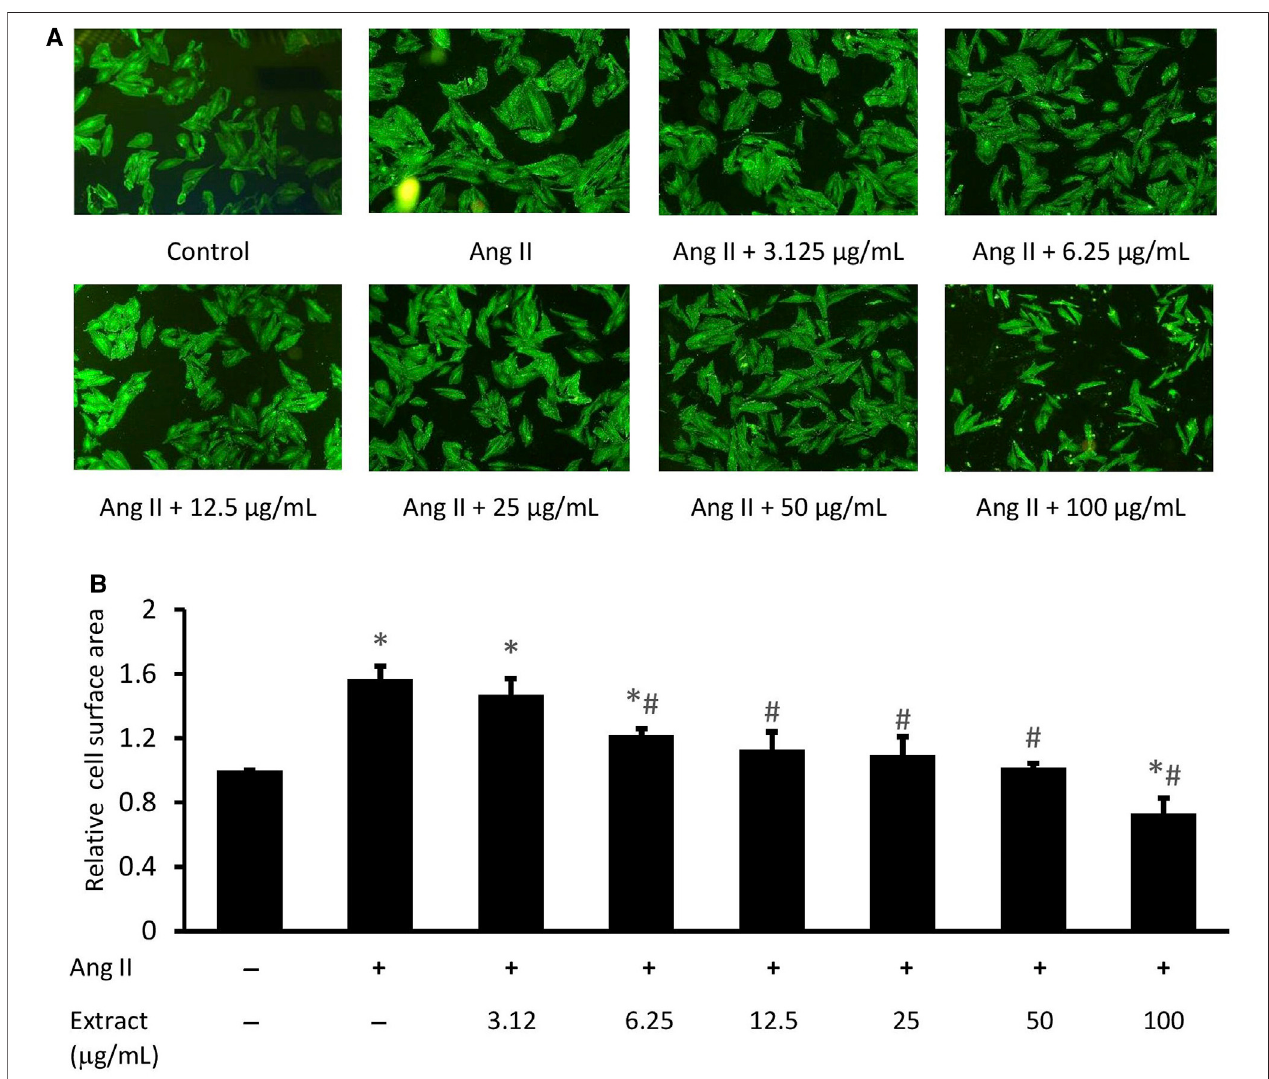
FIGURE6| Effect ofvarious concentrationsof Parkiaspeciosa empty podextractoncellsizeinH9c2 cellsexposedtoAng II(600 nM)for24 h. (A) Representative immuno fl uorescent image (magni fi cation × 100) and (B) quantitative analysis of immuno fl uorescent cells. * p < 0.05 vs. control (no treatment) group. # p < 0.05 vs. Ang II group. Bars represent the mean ± SEM ( n (cid:2) 3).